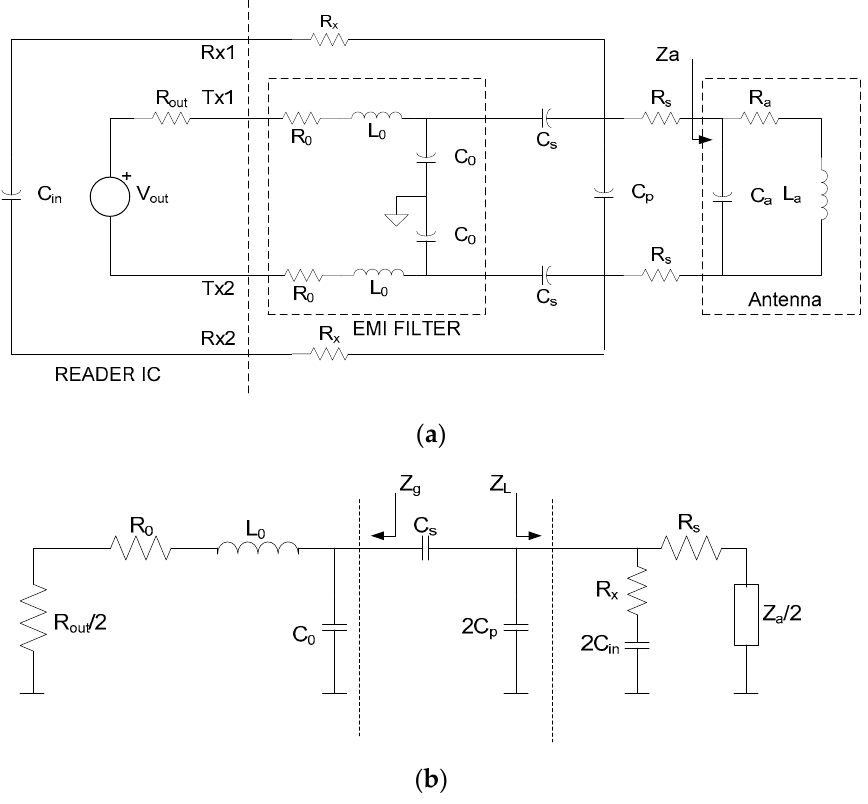
Figure 11. ( a ) Equivalent circuit of the reader, including the electromagnetic interference (EMI) filter and matching network. ( b ) Single-ended equivalent circuit.